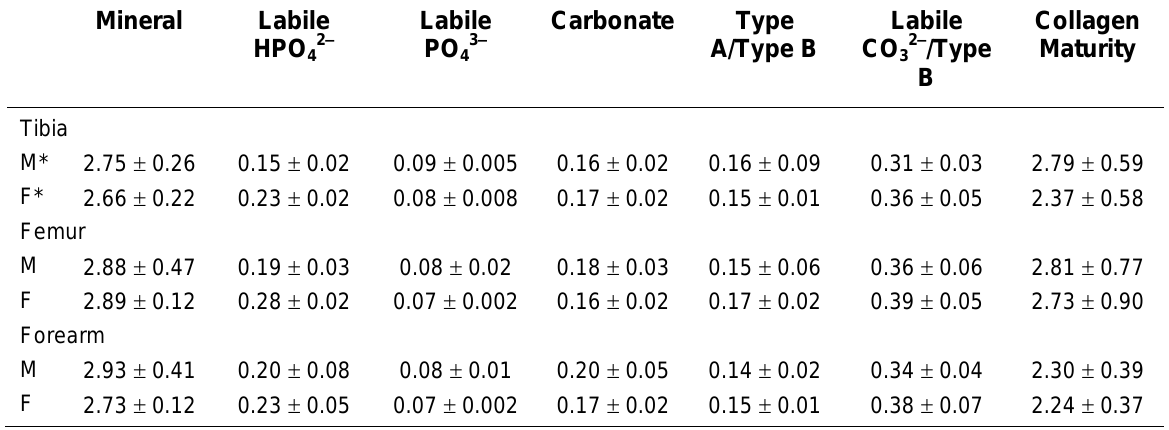
Summary of Parameters Analyzed through Vibrational Spectroscopic